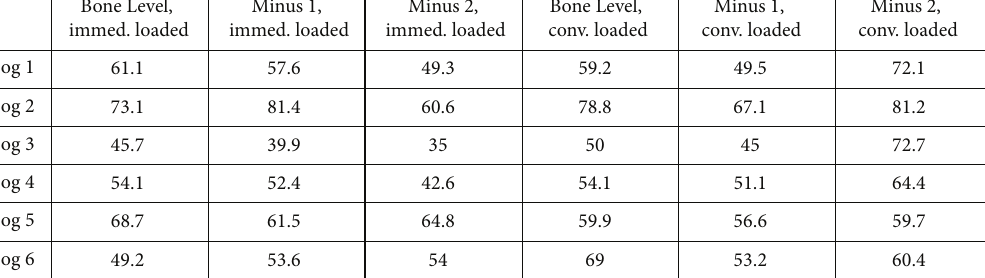
Figure 2: BIC values (%) 90 days after loading for each dog. Immed. loaded = immediately loaded; conv. loaded = conventionally loaded. Statistically significant differences were not observed among groups ( 𝑃 = 0.10 , ANOVA test).